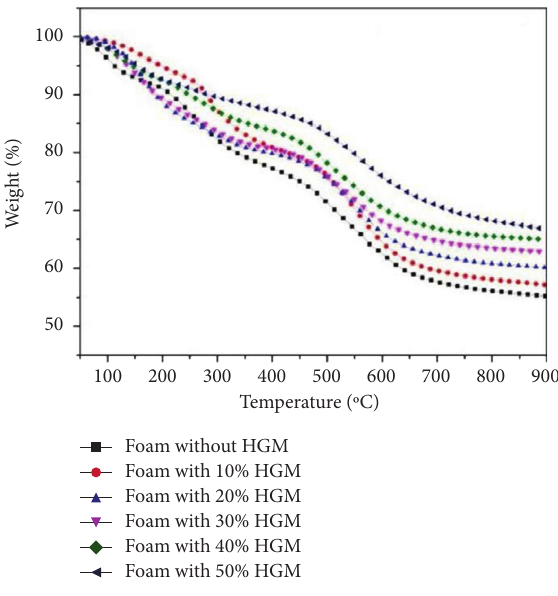
Figure 13: TG curves of HGM/phenolic syntactic foams. Table 2: The thermal weight loss rates of HGM/phenolic syntactic foams at different temperatures. Thermal weight loss rate(%) ( ° C)